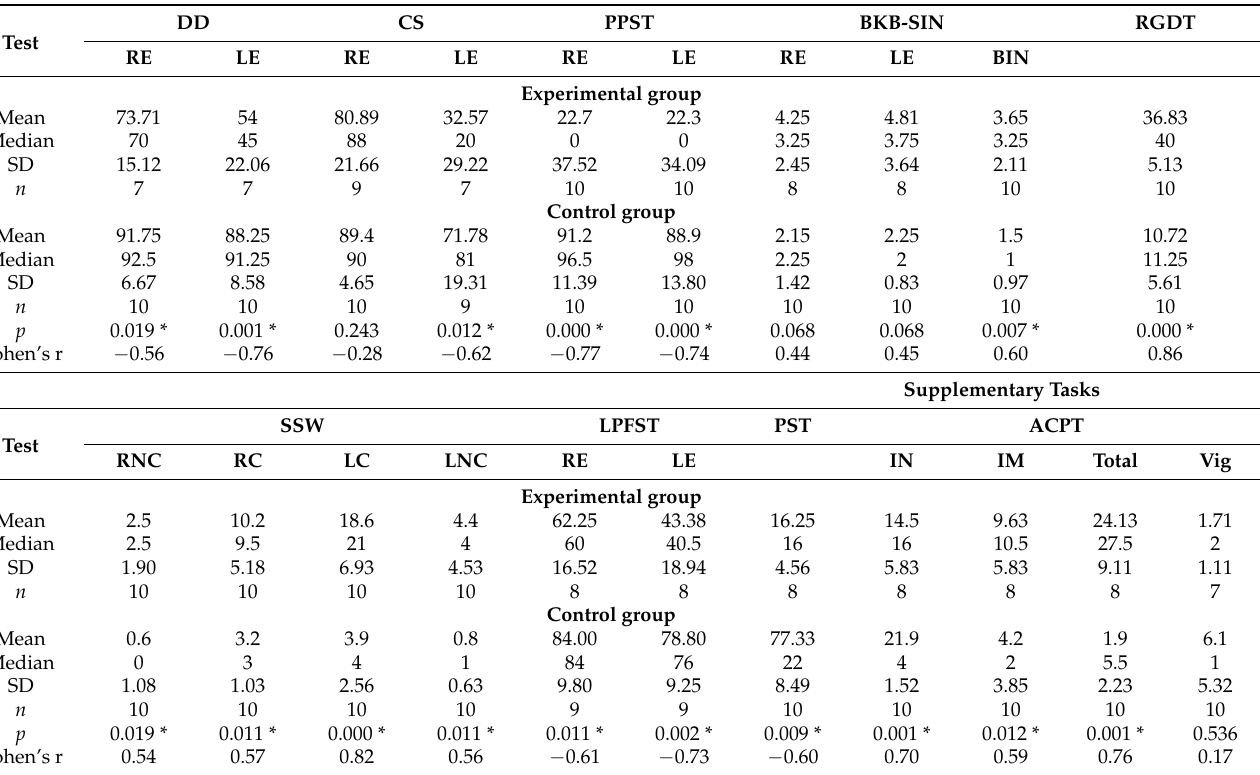
Table 2. Mean, standard deviation (SD) and the number of children ( n ) for both groups, as well as the Mann–Whitney U ( p ) and the effect size (Cohen’s r) between the groups for the auditory behavioural